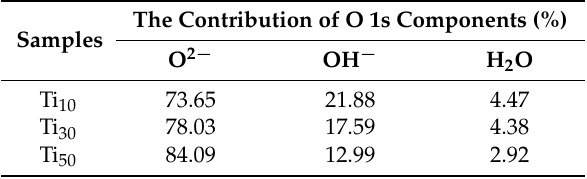
Table 2. The contribution of O 1s components on the surface of Ti 10 , Ti 30 and Ti 50